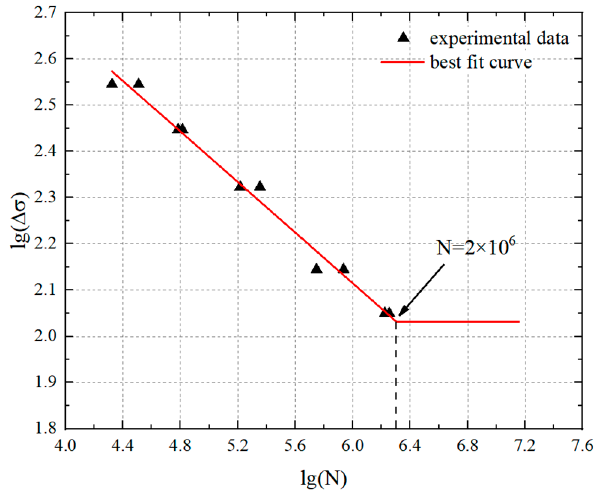
Figure 7. S ‐ N curve of M20 torque ‐ shear HSBs.